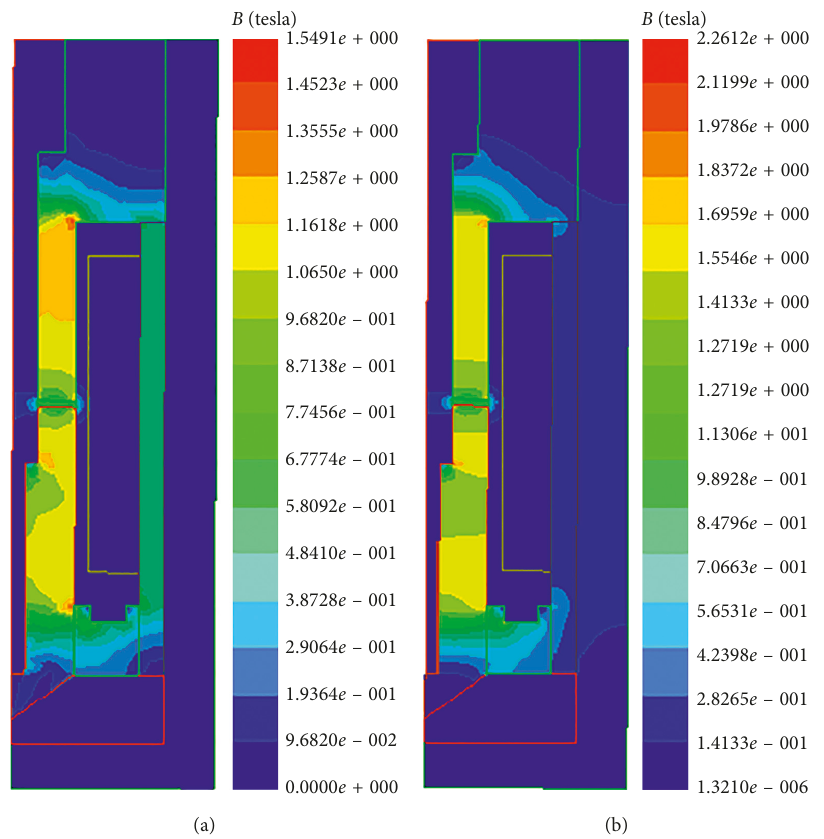
Figure 9: Magnetic induction intensity. (a) 0.8 A. (b) 1.2